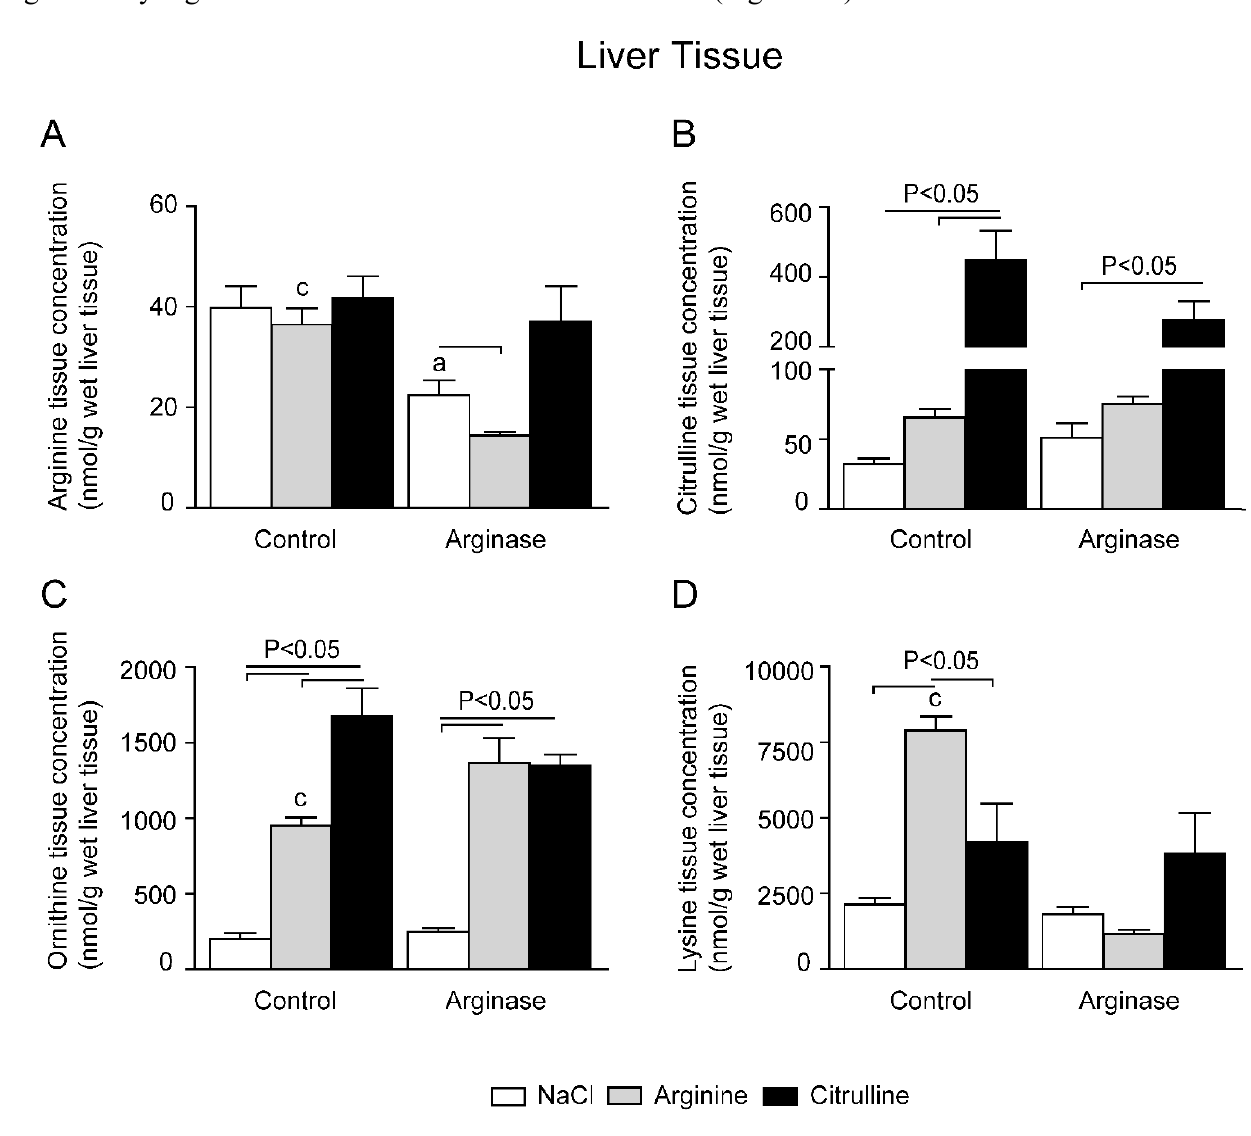
Figure 5. Effect of L -arginine or L -citrulline supplementation on liver tissue amino acid concentrations in control and arginase-treated mice. Liver tissue concentrations during basal and arginase-treated conditions of ( A ) arginine, ( B ) citrulline, ( C ) ornithine and ( D ) lysine were measured with HPLC. Tissue concentrations are displayed as nmol/g wet